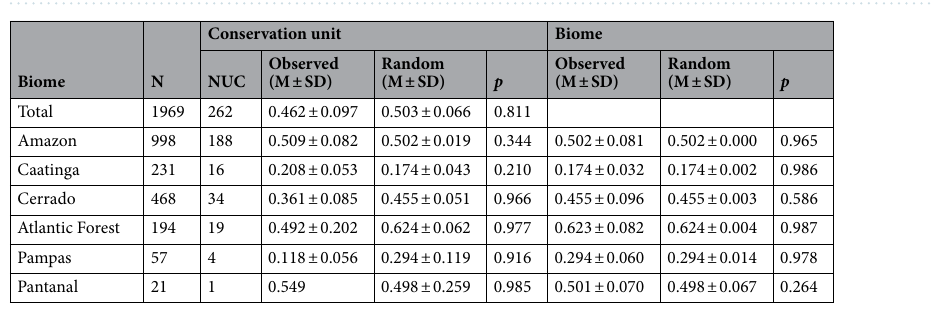
Table 3. Random and observed mean (M) and standard deviation (SD) of importance values for the conservation of Gerromorpha in Brazil (Total) and for each biome. N—number of observed cells in each biome; NUC—number of protected cells in each biome; p—significance value according to the Monte Carlo randomization test.